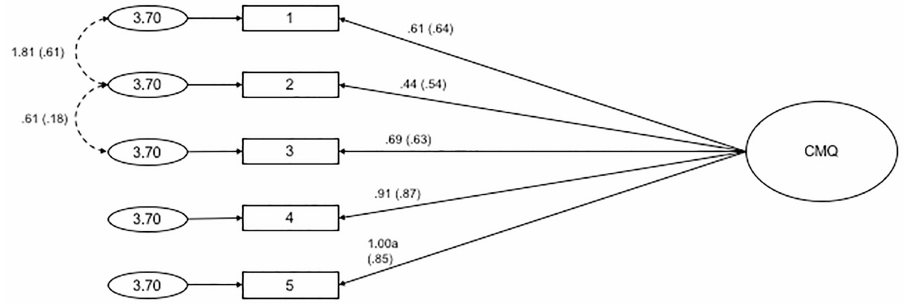
Fig 2. Path diagram and estimatesfor the Conspiracy Mentality Questionnaire. Item numbers in the figure reflect the item numberin Table 5. The large circle is the latent construct, with the rectangles representing measured variables, and the small circles with numbers are the residualvariables(variances). The factor loadingsare standardised in parenthesises, and the unstandarised values outside, with both being reportedfollowingthe guidelinesof Kline [42]. Significance levels were determinedby critical ratios (all p < .001). The factor loadingswere fixed at the indicatedvalue